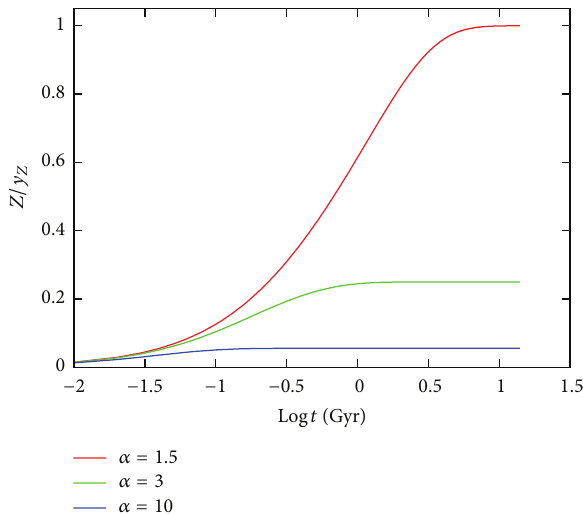
Figure 6: The metallicity of a galaxy, as a function of time, for models with metal-enriched galactic winds. This plot shows the solution of (16) for three different values for the enrichment parameter 𝛼